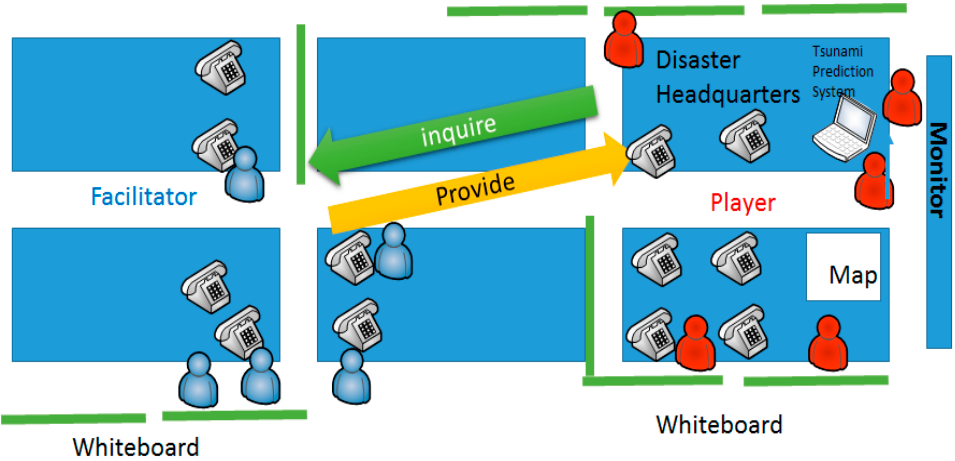
Figure 9. The layout of this TTX at Chiba Prefecture Government. The staff used the Real-Time Tsunami Prediction system using a laptop and a main monitor. The facilitators provide the information in Figure 5 to the players and reply to the inquiries from the players. The facilitators and the players write each situation or information on the whiteboard.